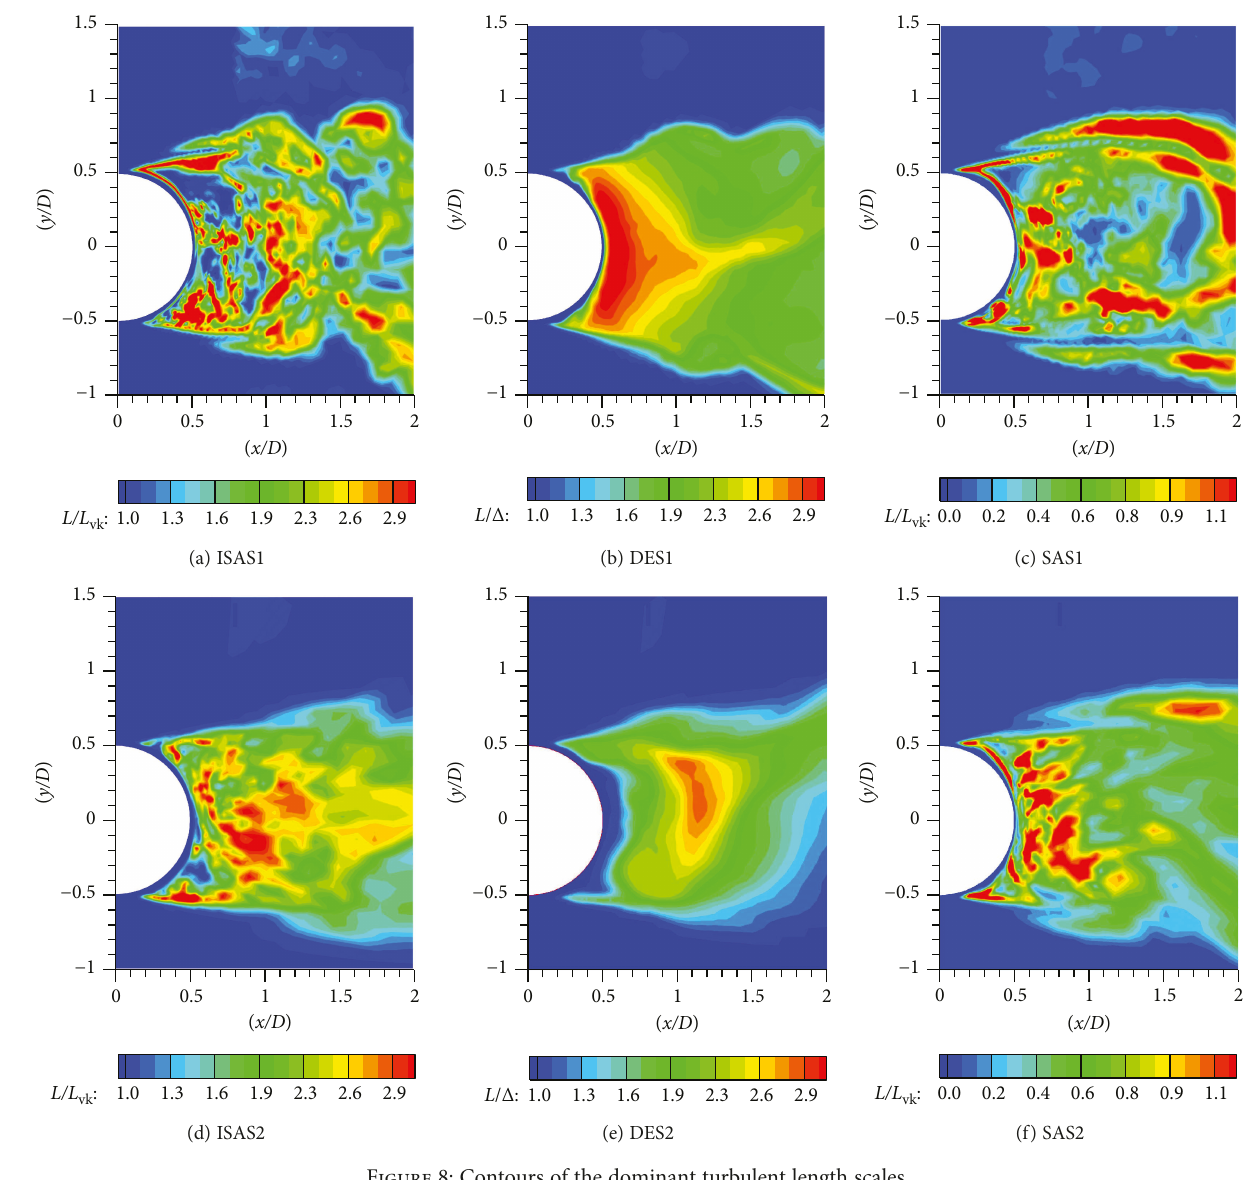
Figure 8: Contours of the dominant turbulent length scales.